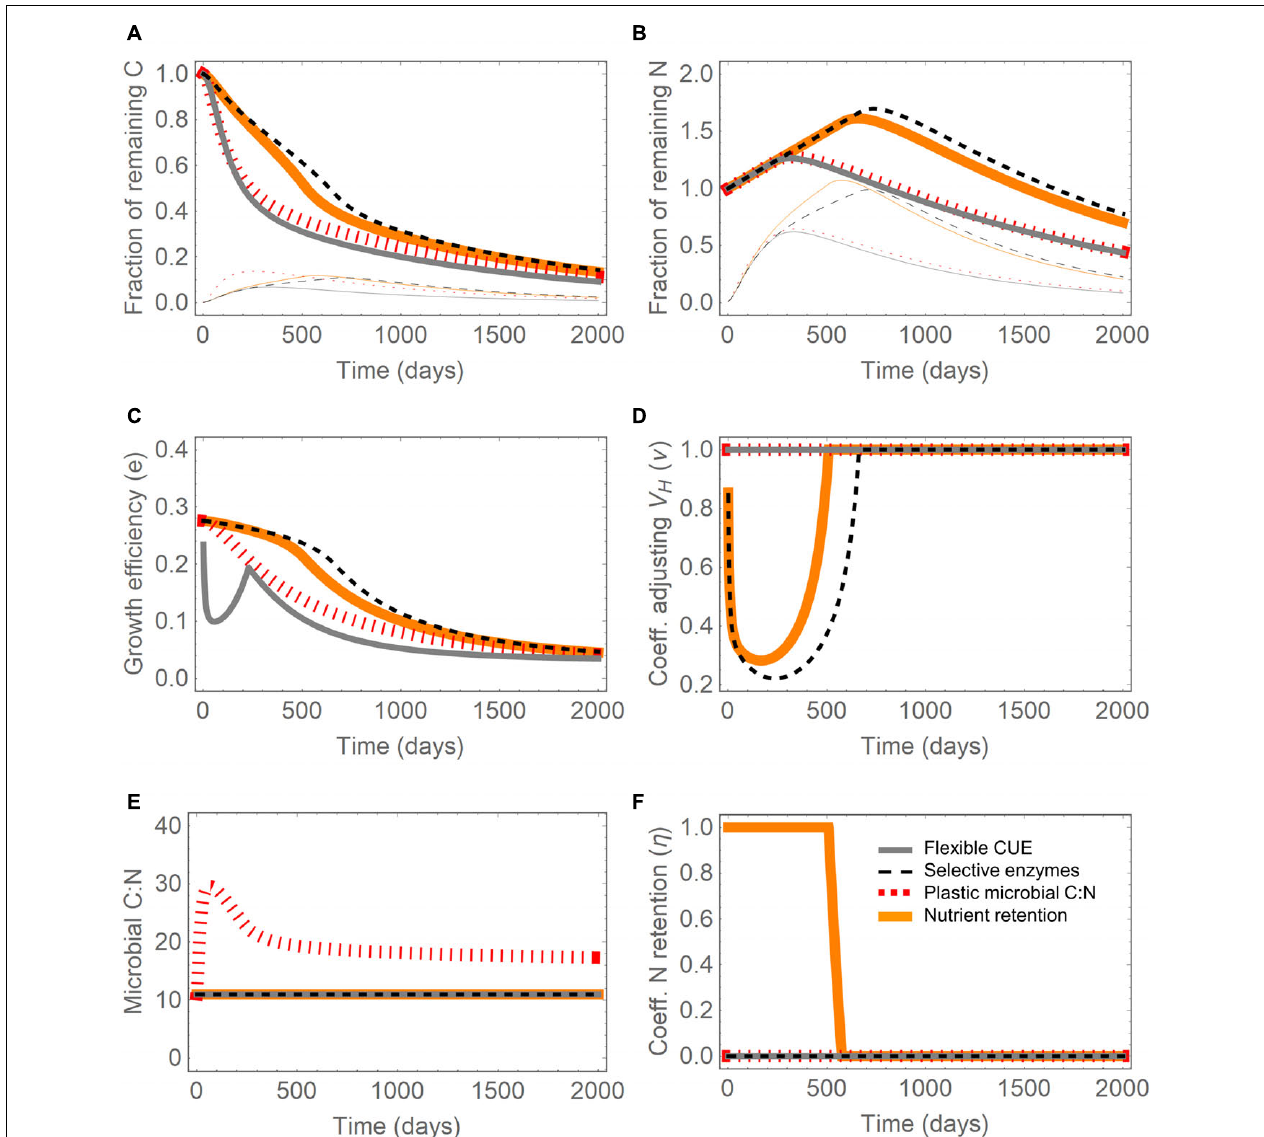
FIGURE 3 | Effect of four resource use modes (different line styles) during decomposition of plant residues: (A) fraction of remaining C (thick lines: total, thin lines: microbial biomass fraction), (B) fraction of remaining N (thick lines: total, thin lines: microbial biomass fraction), (C) growth efficiency (Eq. 22), (D) coefficient adjusting C H decomposition rate, ν (Eq. 23), (E) microbial biomass C:N ratio, and (F) N retention efficiency, η (Eq. 25). Initial conditions (normalized by the total initial C): C H (0) = 0.78, C P (0) = 0.02, C O (0) = 0.20, C S (0) = 10 − 3 ; initial N contents are obtained by imposing ( C : N ) P = 4, ( C : N ) B = 11, and determining ( C : N ) O = 41 from a total litter C:N = 100. Parameter values are as in Figure 2 . Note that in most panels several lines overlap, especially under C